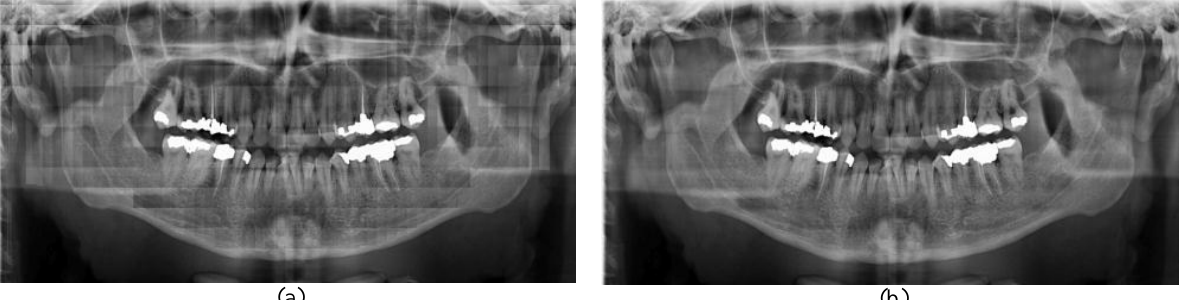
Figure 5. (a) Image enhancement with blocking effects in gamma correction, (b) Image enhancement without the problem of blocking effect.